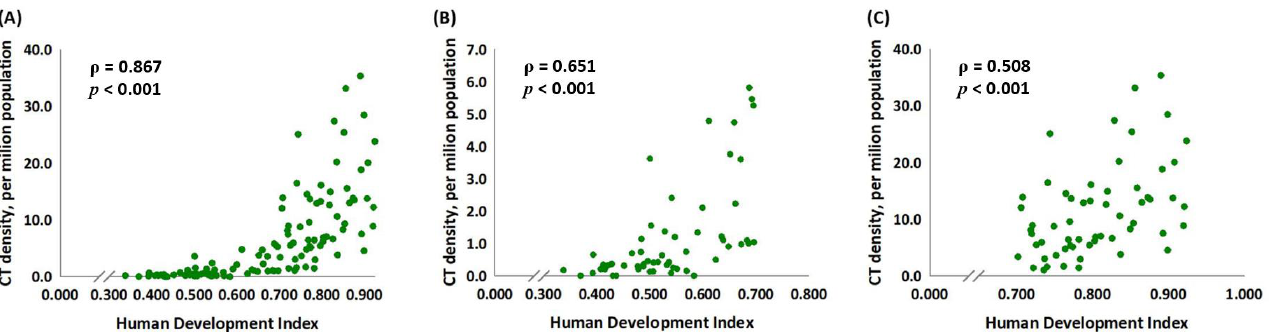
Figure 1. The human development index of ( A ) all selected countries ( n = 115) and of countries with ( B ) HDI scores <0.70 ( n = 56) and ( C ) HDI scores ≥0.70 ( n = 59) are significantly associated with CT density.